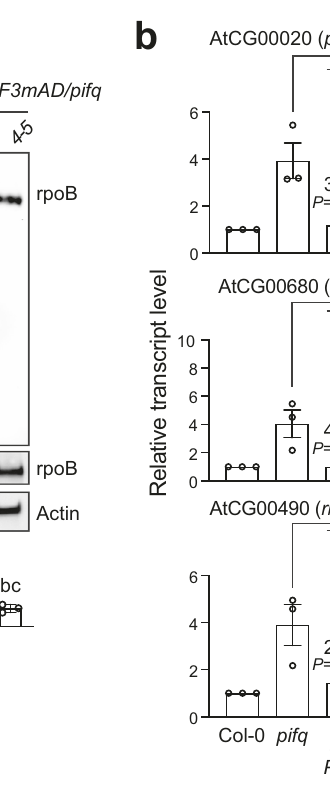
three biological replicates, and the centers of the error bars represent the mean values. b qRT-PCR analysis of the steady-state transcript levels of select PhAPGs, including psbA , psbB ,and rbcL ,inthe4-d-olddark-grownseedlingsshownin a .The transcript levels were calculated relative to those of PP2A . Error bars represent the s.e. of three biological replicates, and the centers of the error bars represent the mean values. Asterisks indicate statistically signi fi cant differences between the indicatedtransgeniclinesand pifq basedontwo-tailedStudent ’ s t -test( * P ≤ 0.05).If the change was less than two-fold or not statistically signi fi cant, it is labeled as n.s. (not signi fi cant). The source data underlying the immunoblots in a and the qRT- PCR analysis in b are provided in the Source Data fi